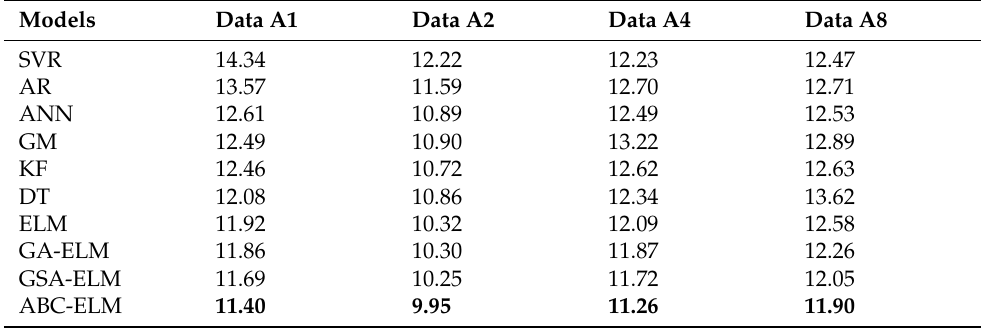
Table 3. The MAPE(%) of different forecasting models under four datasets.